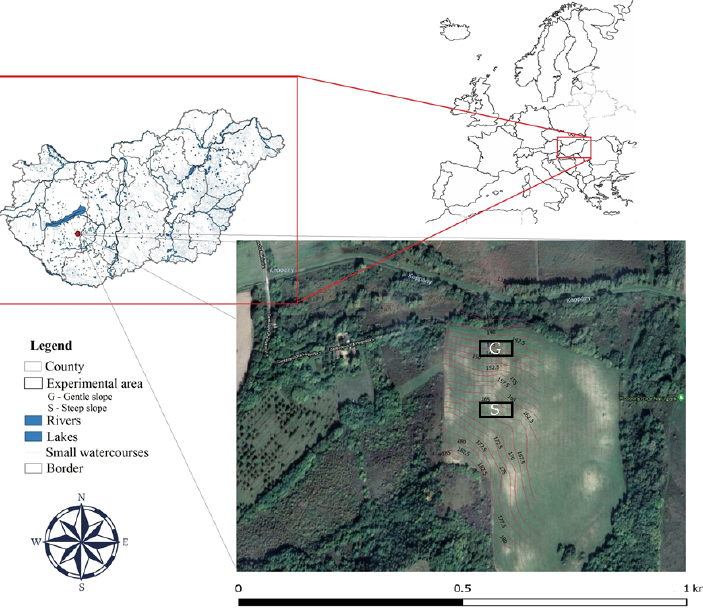
Figure 1. The situation of the study site and the experimental area within the field. The in situ experiments were performed on freshly tilled Regosol, on gentle slopes (6.7%, 8.0% and 7.7%) and on steep slopes (18.32%, 17.26% and 17.5%), in 3 repetitions. The soil properties of the 0–30 cm layer are reported in Table